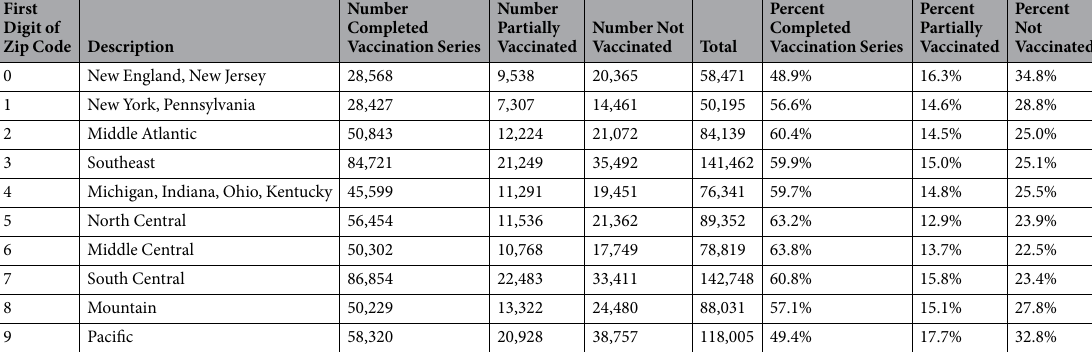
Table 5. Percentage of Infants Receiving Rotavirus Vaccination by Area, 2006–2017.